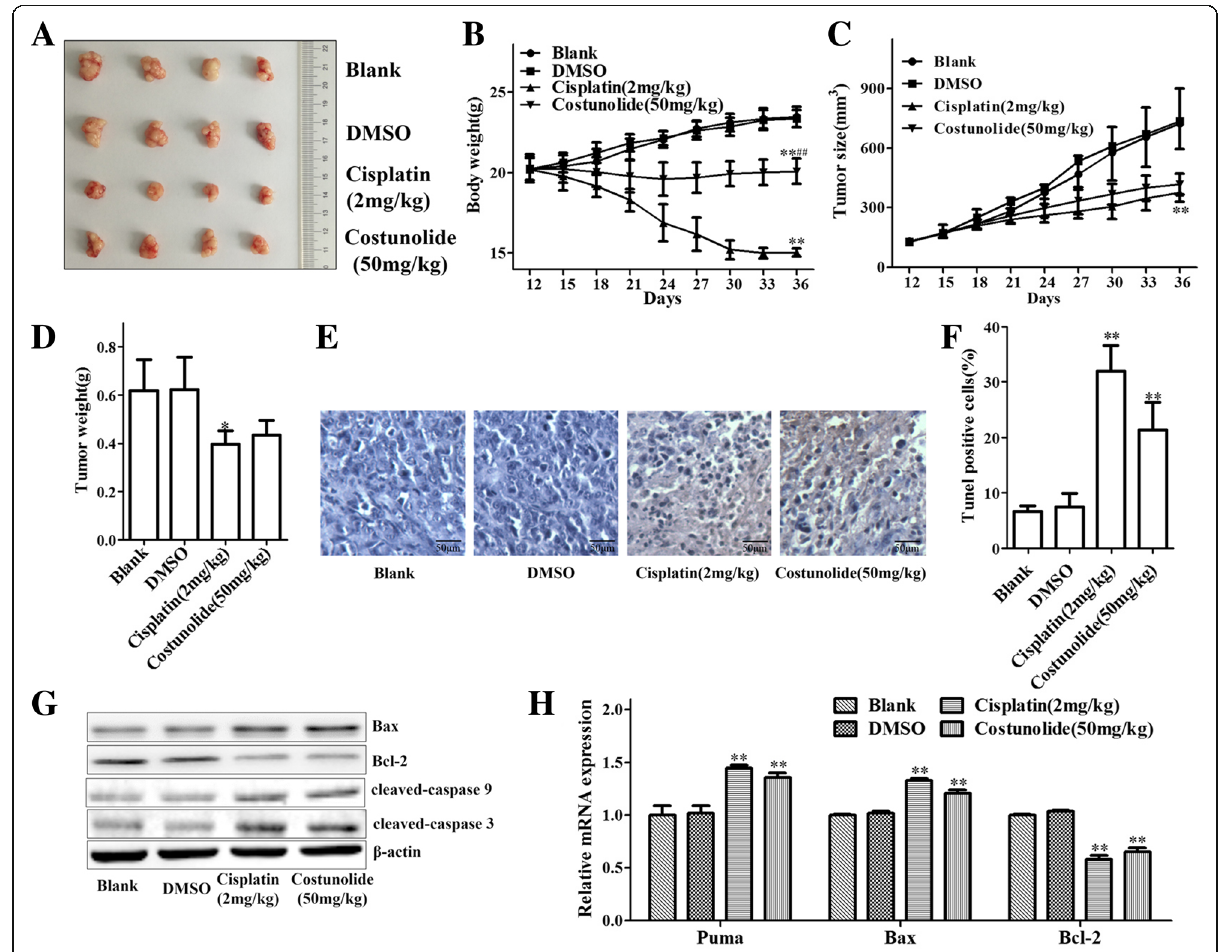
Fig. 4 Costunolide inhibited the growth and induced mitochondria-mediated apoptosis of gastric tumor in xenografted nude mice. a Photograph of gastric tumor is taken after sacrificing mice. There are 4 groups: blank, DMSO, cisplatin (2 mg/kg) and costunolide (50 mg/kg) group. b Body weight of mice was measured every three day. c Tumor size of mice was measured by vernier caliper every three day. d Tumor weight of mice was measured after sacrificing mice. e Tunel staining of gastric tumor. f Statistical data of Tunel staining positive cells. g Apoptosis related proteins (Bax, Bcl-2, cleaved caspase 9, cleaved caspase 3, β -actin is internal reference protein) of gastric tumor of nude mice is detected by WB. h Apoptosis related genes (puma, Bax and Bcl-2, GAPDH is internal reference gene) expression of gastric tumor is detected by Q-PCR. Compared to control group, * P < 0.05, ** P < 0.01. Compared to cisplatin group, # P < 0.05, ## P <